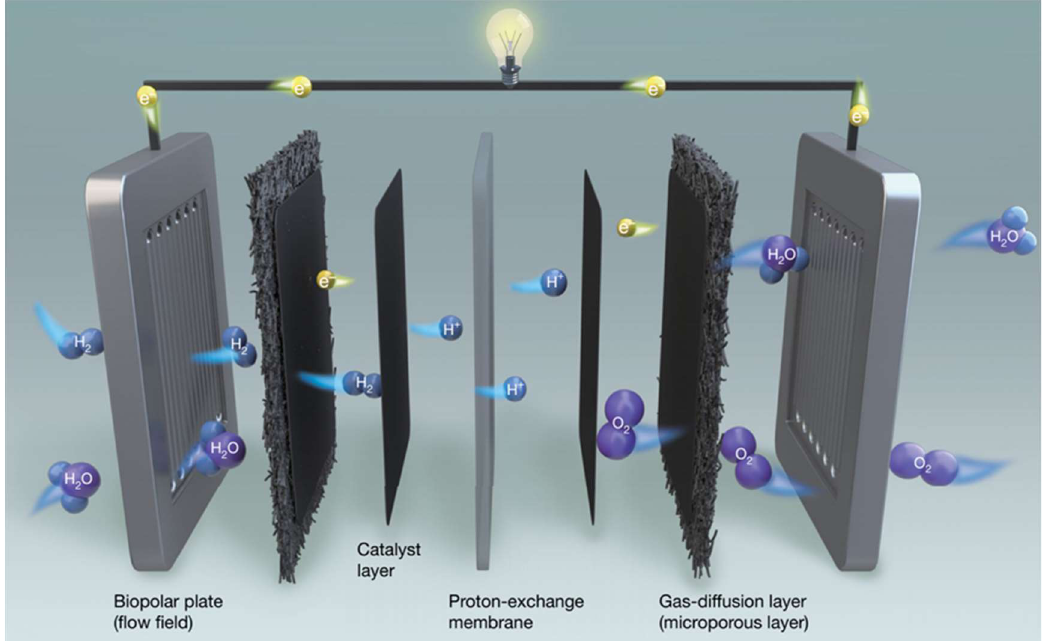
Figure 9. Composition of PEMFCs and electron and charge transport during operation. Reproduced from ref. [17] with permission from Springer Nature, copyright 2021.